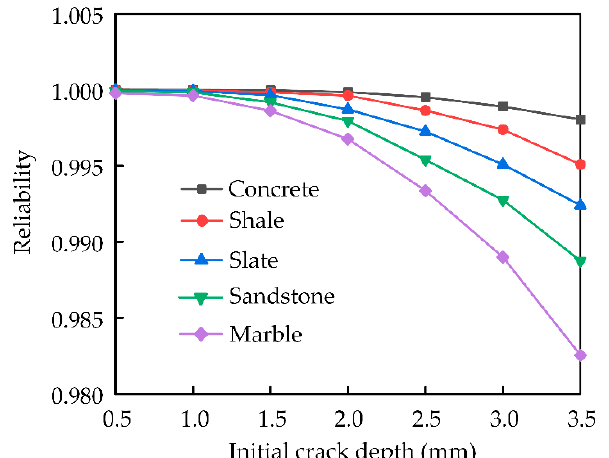
Figure 9. Relationship between the reliability of the cutterhead and the initial crack depth.